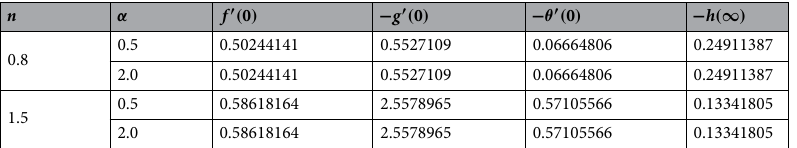
Table 2. Numerical results of f ′ ( 0 ) , g ′ ( 0 ) , θ ′ ( 0 ) and Pr 2, r 0.6 and disk thickness index m = =